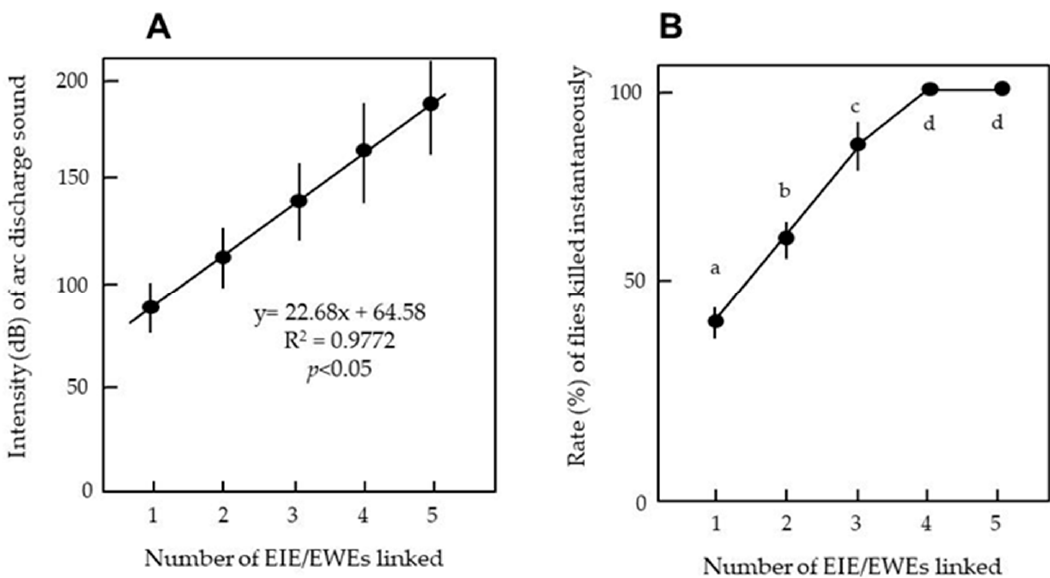
Figure 6. Relationships between the numbers of linked EIE / EWEs and the intensity of the arc-discharge sound ( A ) and the percentage of flies killed instantaneously ( B ). Twenty adult houseflies were used for each apparatus, and the means and standard deviations were calculated from five replicates of the experiments. The letters ( a–d ) indicate significant differences ( p < 0.05) determined by Tukey’s test.